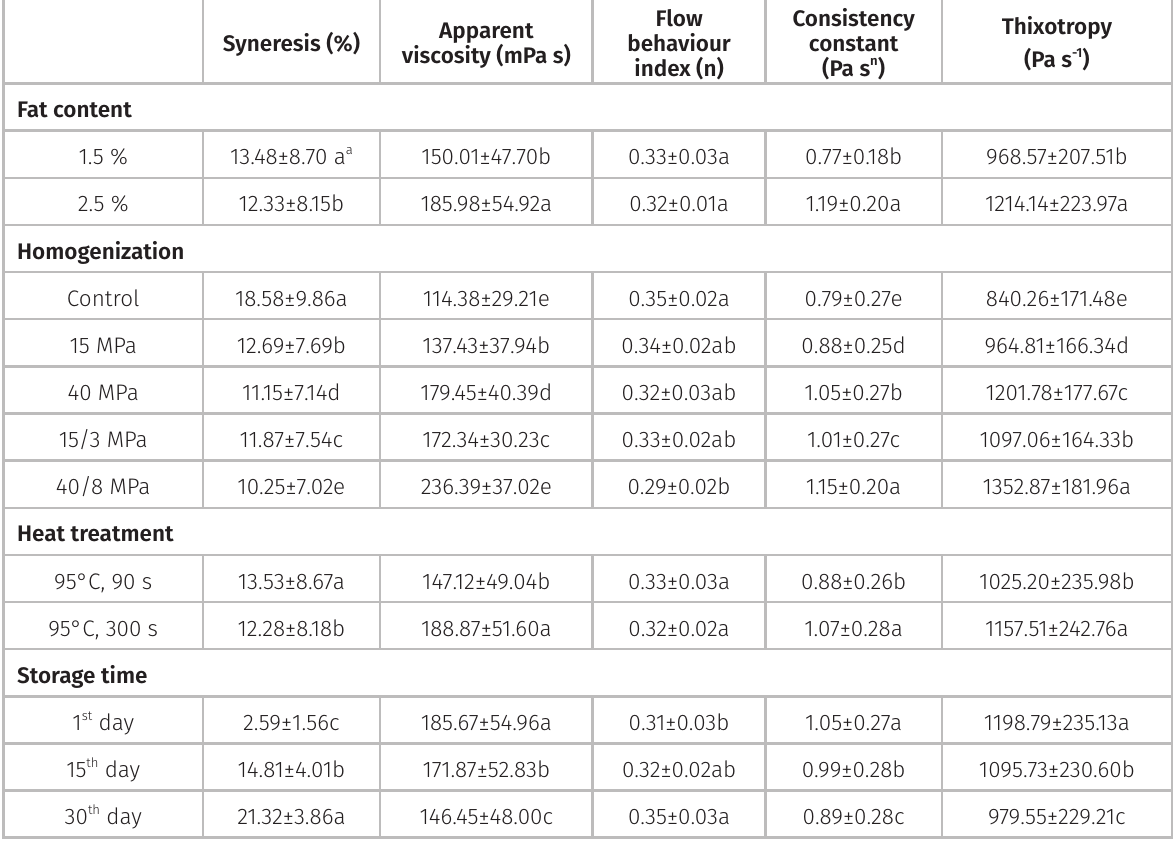
a Values are the means ± standard error (n = 2); different superscript letters for each parameter in a column show significant difference at